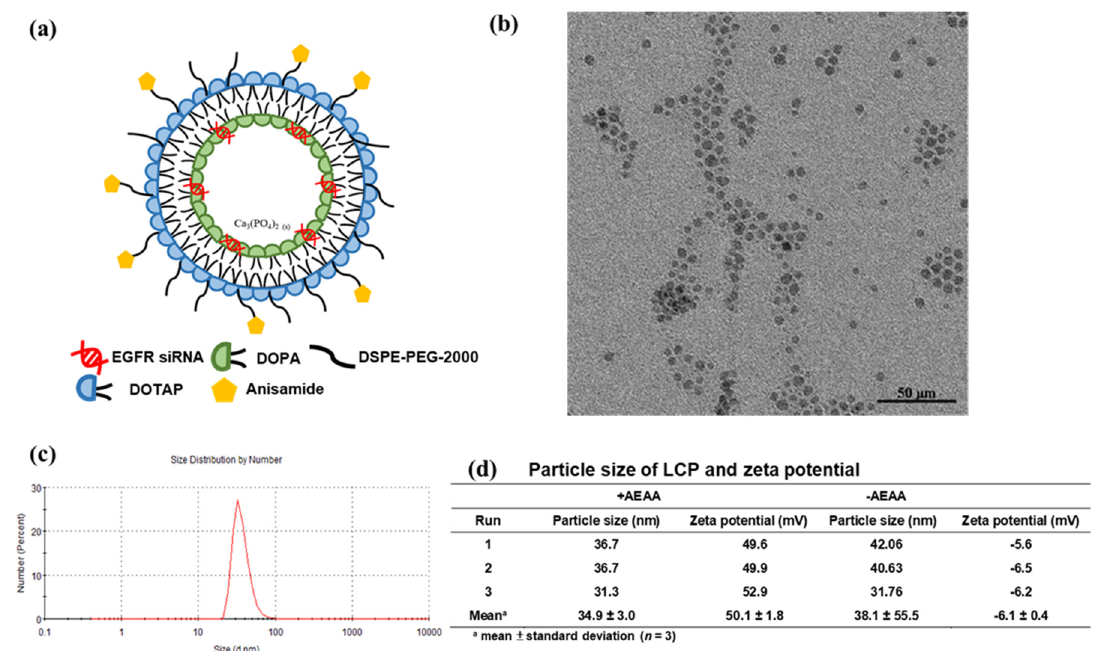
Figure 3. Characteristic Properties of LCP siEGFR NPs. ( a ) Demonstration of LCP siEGFR NPs. LCP Pyro PA NPs were formulated with two different types of phospholipids to form double-layer liposomal nanoparticles that were composed of pH sensitive calcium phosphate cores stabilized by DOPA and coated with DOTAP. The outer part of the lipid layer was modified with polyethylene glycol (PEG) chains and aminoethylanisamide (AEAA). AEAA is the targeting ligands for the sigma receptors on cancer cell surfaces ( b – d ). Data presented as mean ± SD (in triplicate).